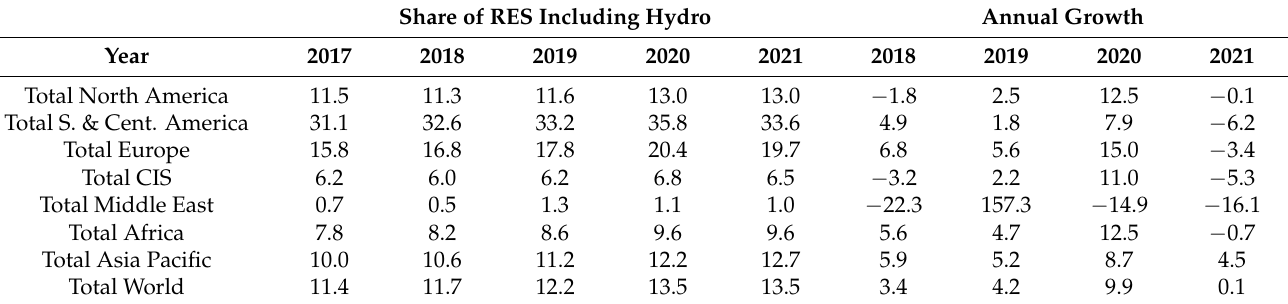
Table 7. Energy consumption,